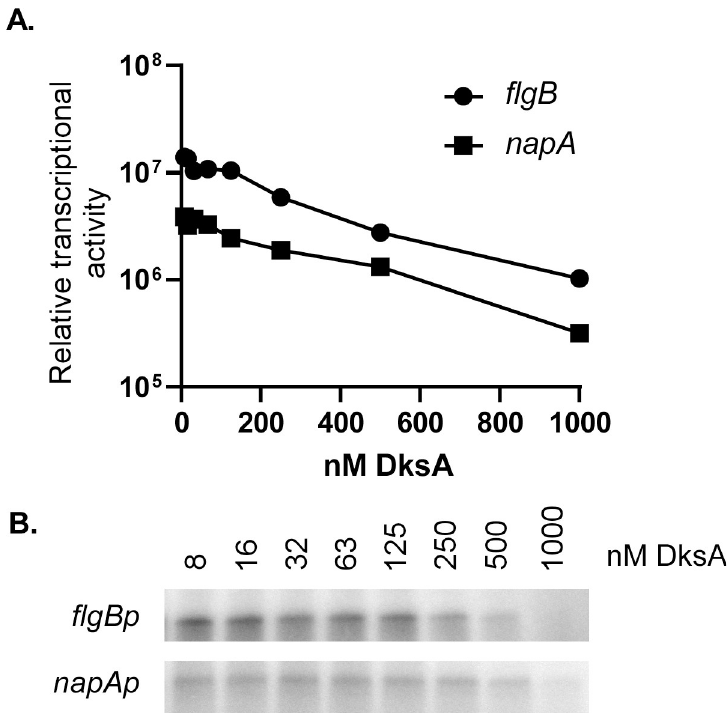
Fig 3. Test of DksA concentration-dependent regulation of flgB and napA . Relative RNA product amounts after in vitro transcription reactions containing various concentrations (8–1000 nM) of DksA. Two promoters flgBp and napAp which appeared to have different levels of response to DksA in Fig 2A were tested. Signal intensity as measured by isotopically labeled RNA and determined by densitometry (A) of phosphor screen images (B) are shown.